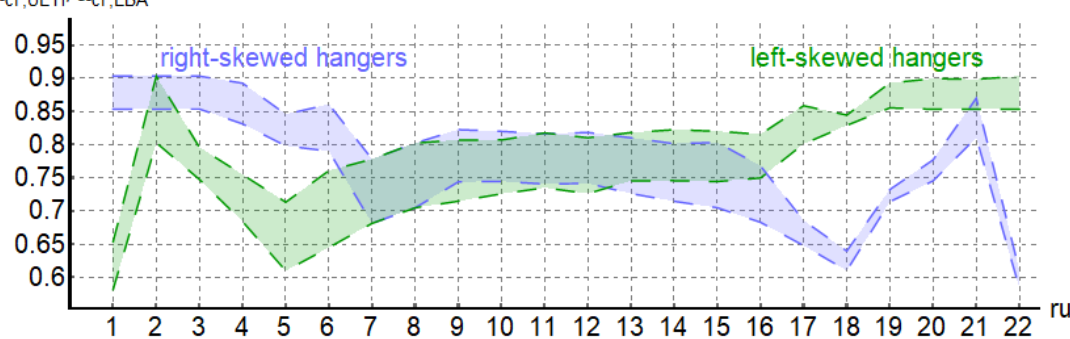
Figure 21: The range of ULTI-to-LBA critical load factor ratios for breaking one hanger at once.